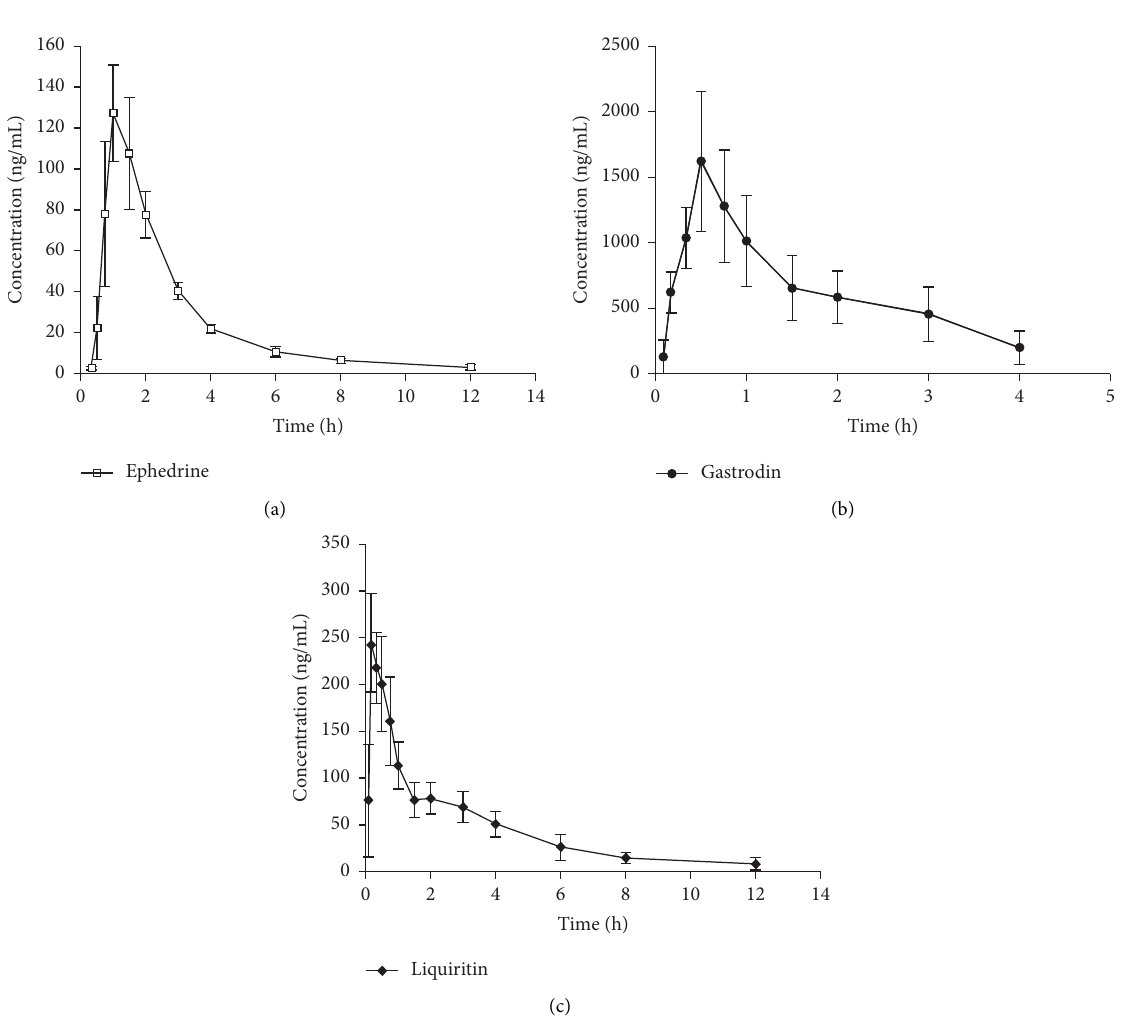
Figure 4: Te mean plasma concentration-time curves of ephedrine (a), gastrodin (b), and liquiritin (c) ( n � 6).